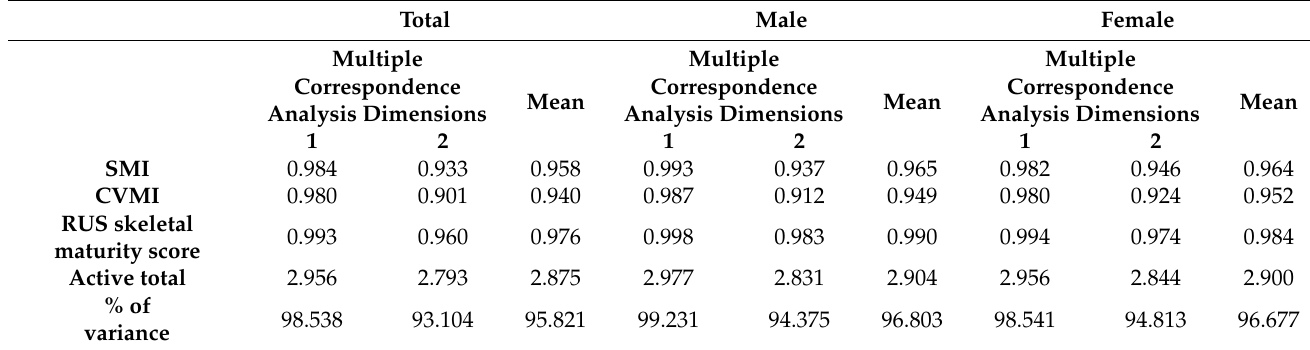
Table 3. Multiple correspondence analysis dimensions discrimination